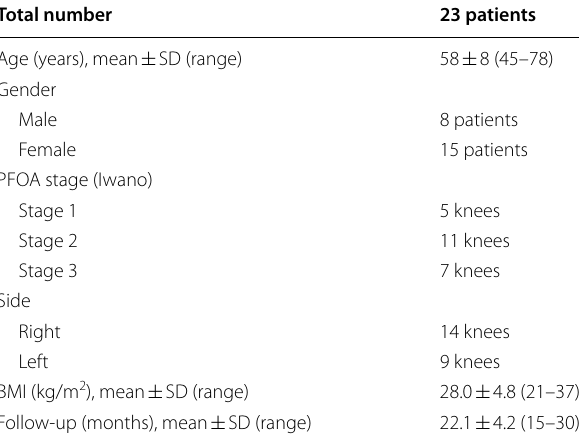
Table 2 Mean SD (range) of IKS knee and function and VAS ± scores